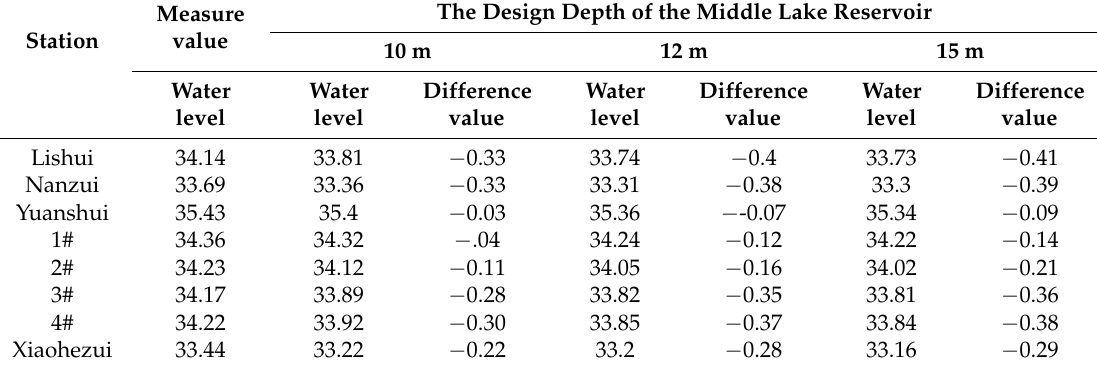
Table 2. The influence of different design depth on the peak water elevation